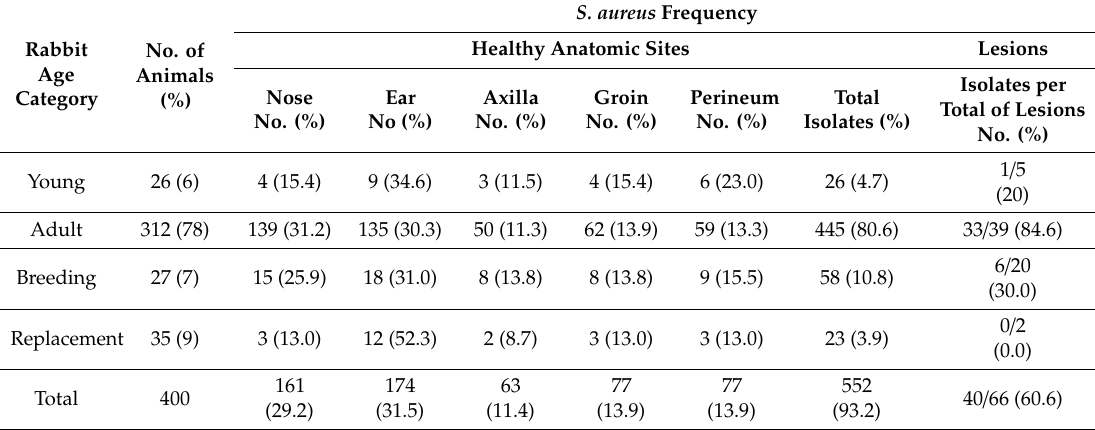
Table 1. Sampling distribution and prevalence of Staphylococcus aureus : S. aureus frequencies by age animal category, healthy anatomic site, and